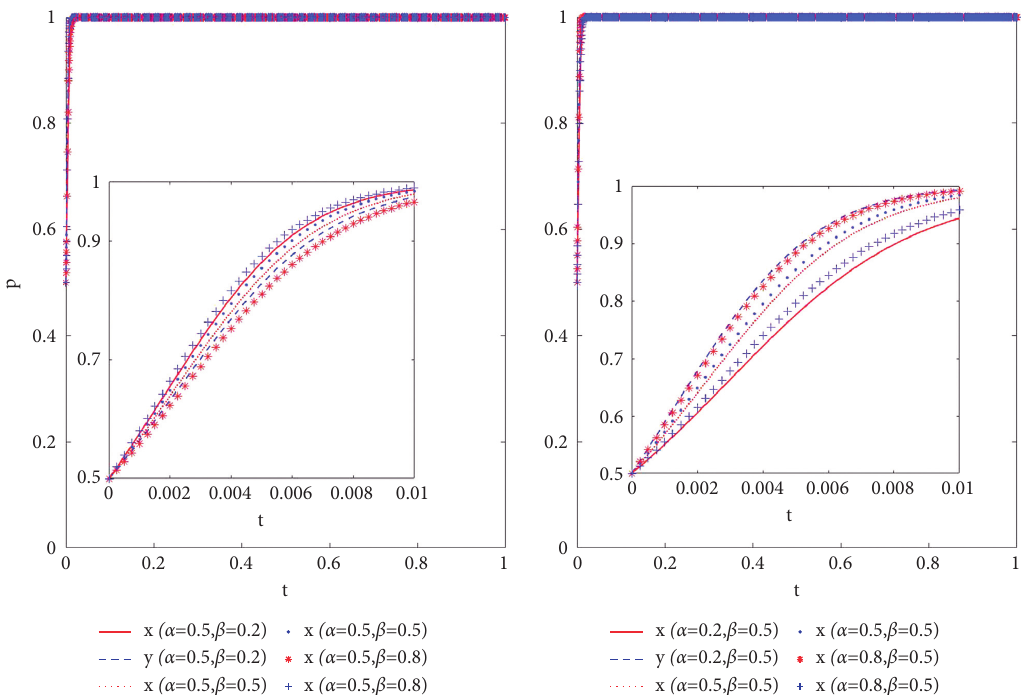
Figure 8: Influence of revenue sharing coefficient and cost sharing coefficient on system evolution